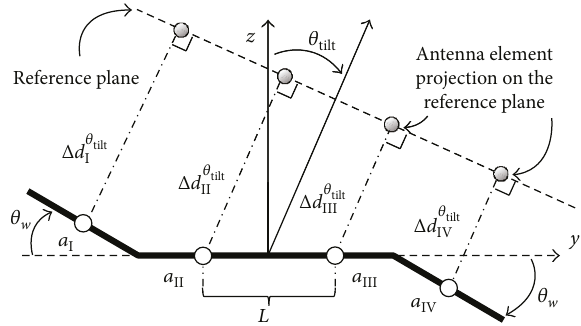
Figure 2: Representation of the pattern recovery with the PM for a deformed 4 × 4 array whose beam is tilted of θ tilt : the reference plane is chosen among the in fi nite ones perpendicular to the direction of the maximum θ tilt , and phase shifts related to the distances Δ d θ tilt n are introduced in the n th element (see Section 2).